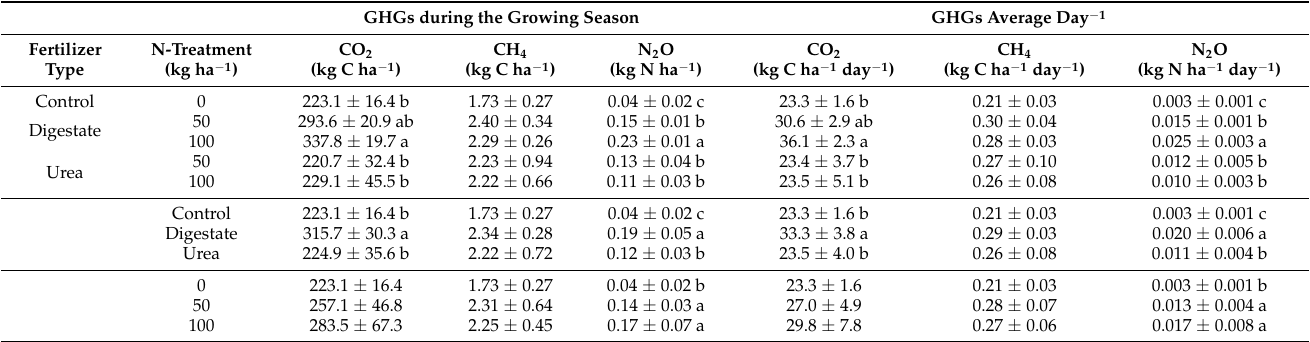
Table 3. Total cumulative GHG emissions during the growing season and daily GHG fluxes. GHGs during the Growing